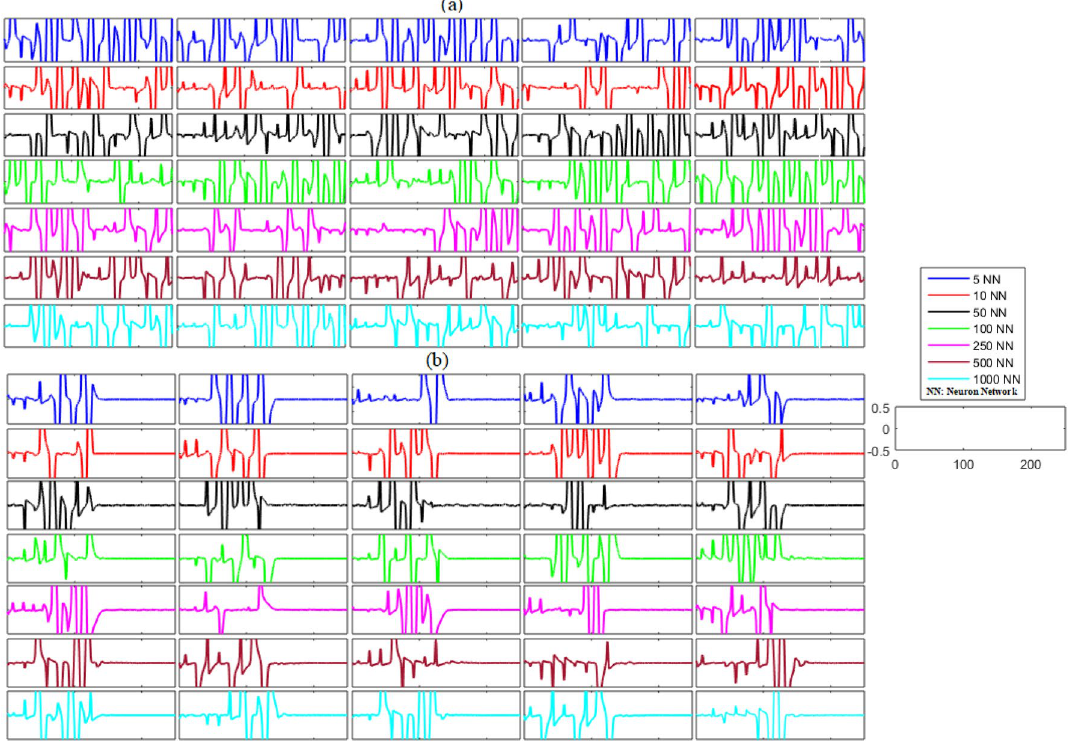
Figure 9. ( a ) Without control synchronization dynamics of the recovery variable states (y-states) of different time-delayed bidirectional FHN networks with noise. ( b ) Controlled synchronized error dynamics of the recovery variable states (y-states) of different time-delayed bidirectional FHN neuronal networks with noise.